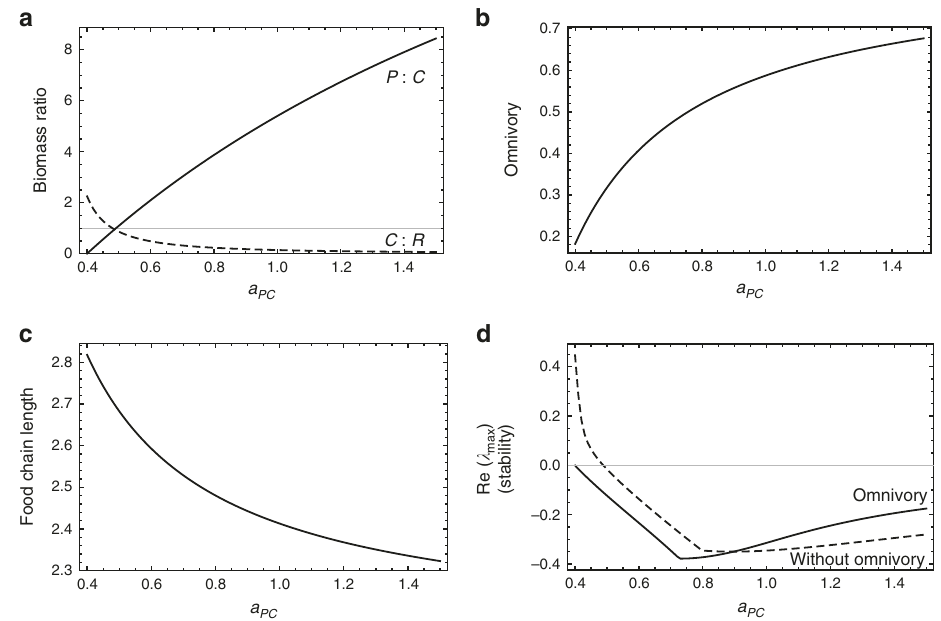
Fig. 1 Predicting food-chain length from the energy fl ux mechanism. Equilibrium solutions from Eq. 1 for the effect of increasing a PC on a biomass pyramid shape (i.e., biomass ratios of P : C , and C : R ), b the degree to which P is omnivorous, c food-chain length, and d stability (for systems with and without omnivory), for the following parameters: r = 2.0, K = 3.0, a CR = 1.1, a PR = 0.2, e CR = 1.0, e PC = 1.0, e PR = 1.0, m C = 0.7, m P = 0.7. Increasing e or K produces qualitatively similar